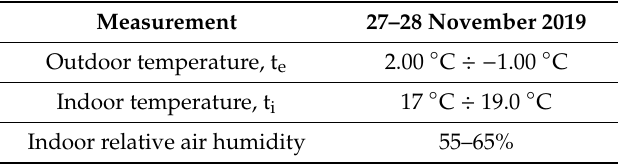
Table 2. Testing conditions.